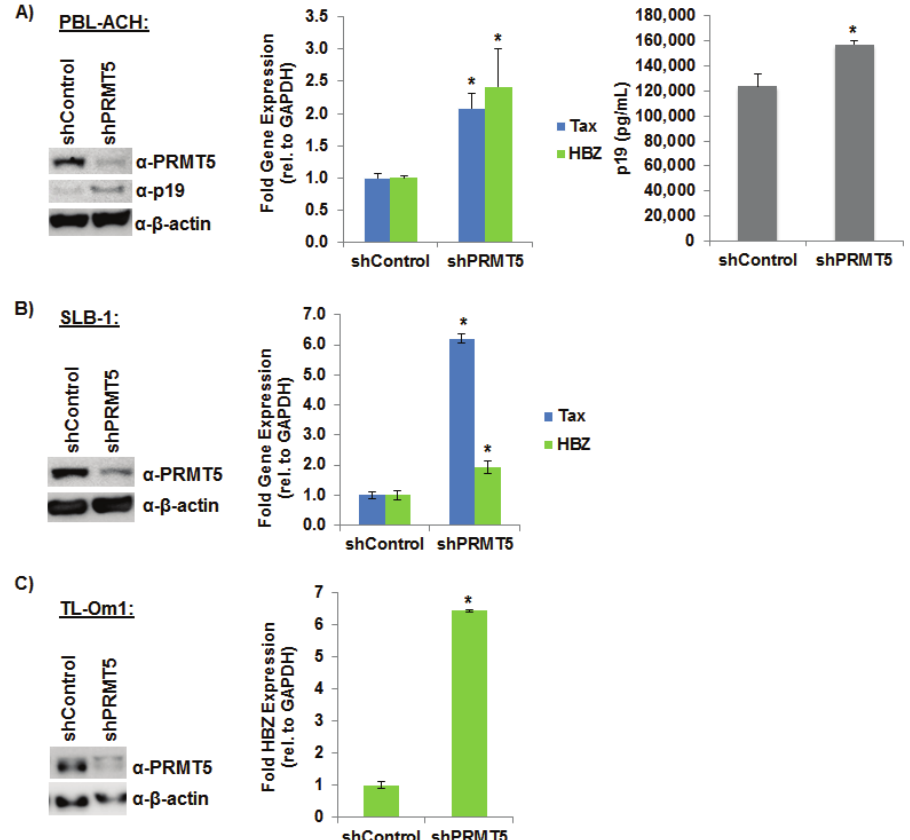
Figure 3. Loss of endogenous PRMT5 increased HTLV-1 gene expression. ( A ) PBL-ACH cells (HTLV-1-transformed) were infected with a pool of five different lentiviral vectors directed against PRMT5, or control shRNAs. The cells were selected for 7 days using puromycin. Immunoblot analysis was performed to compare the levels of PRMT5, p19 (Gag), and β -actin (loading control) in each condition (left panel). Quantitative RT-PCR (middle panel) for Tax, HBZ, and GAPDH was performed on mRNA isolated from shControl and shPRMT5 cells. Transcript levels were determined using the ΔΔ Ct method and normalized to relative GAPDH levels. Levels of Tax and HBZ relative to GAPDH in shControl cells were set to 1. Data are presented in histogram form with means and standard deviations from triplicate experiments. HTLV-1 gene expression was quantified by the detection of the p19 Gag protein in the culture supernatant using ELISA (right panel); ( B ) SLB-1 cells (HTLV-1-transformed) were infected with a pool of five different lentiviral vectors directed against PRMT5 or control shRNAs. The cells were selected for 7 days using puromycin. Immunoblot analysis was performed to compare the levels of PRMT5 and β -actin protein (loading control) in each condition (left panel). Quantitative RT-PCR for Tax, HBZ, and GAPDH was performed on mRNA isolated from shControl and shPRMT5 cells (right panel). Transcript levels were determined using the ΔΔ Ct method and normalized to relative GAPDH levels. Data are presented in histogram form with means and standard deviations from triplicate experiments. Levels of Tax and HBZ relative to GAPDH in shControl cells were set to 1; ( C ) TL-Om1 cells (ATL-derived, Tax-negative) were infected with a pool of five different lentiviral vectors directed against PRMT5, or control shRNAs. The cells were selected for 7 days using puromycin. Immunoblot analysis was performed to compare the levels of PRMT5 and β -actin protein (loading control) in each condition (left panel). Quantitative RT-PCR for HBZ and GAPDH was performed on mRNA isolated from shControl and shPRMT5 cells (right panel). HBZ transcript level was determined using the ΔΔ Ct method and normalized to relative GAPDH levels. Data are presented in histogram form with means and standard deviations from triplicate experiments. Levels of HBZ relative to GAPDH in shControl cells were set to 1. Student’s t test was performed to determine significant differences in viral transcript levels between shControl and shPRMT5 cells; p < 0.05 (*).